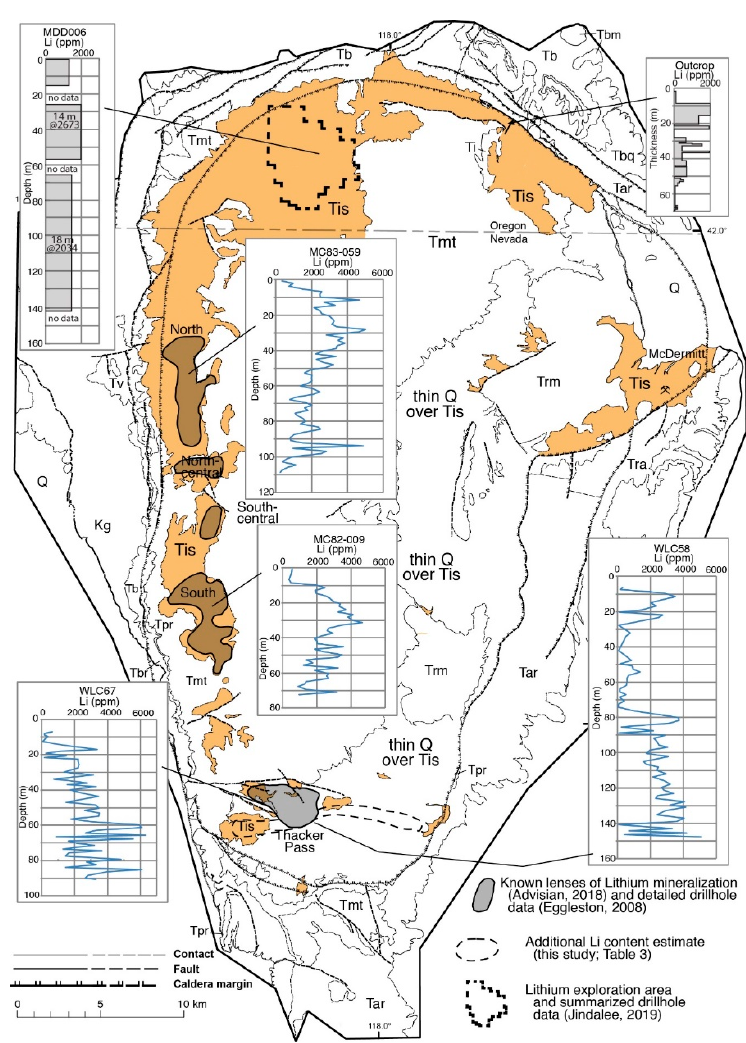
Figure 5. Areas of Li mineralization identified by Lithium Nevada Inc. and Jindalee Resources Inc. with representative lithium contents of drill holes and outcrop. Tuffaceous sediments throughout the caldera are highly enriched in lithium.